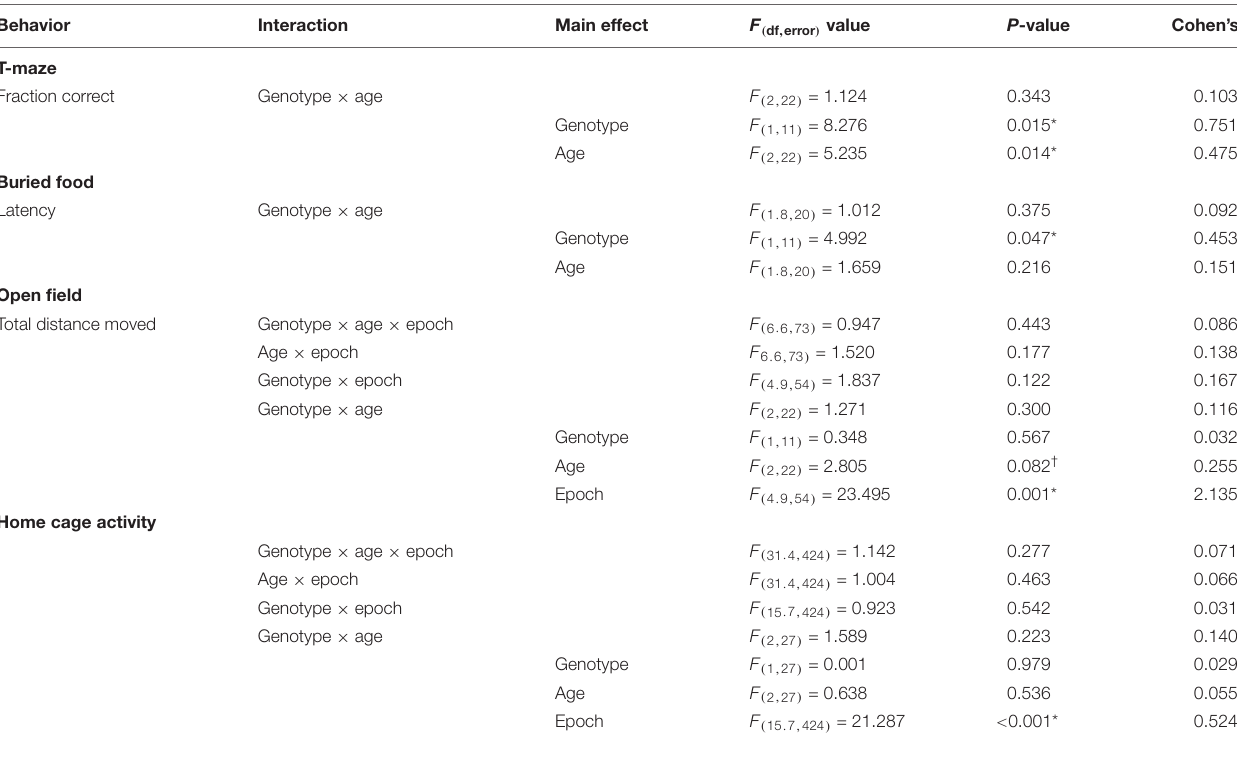
TABLE 1 | Repeated measures ANOVA results behavior testing in